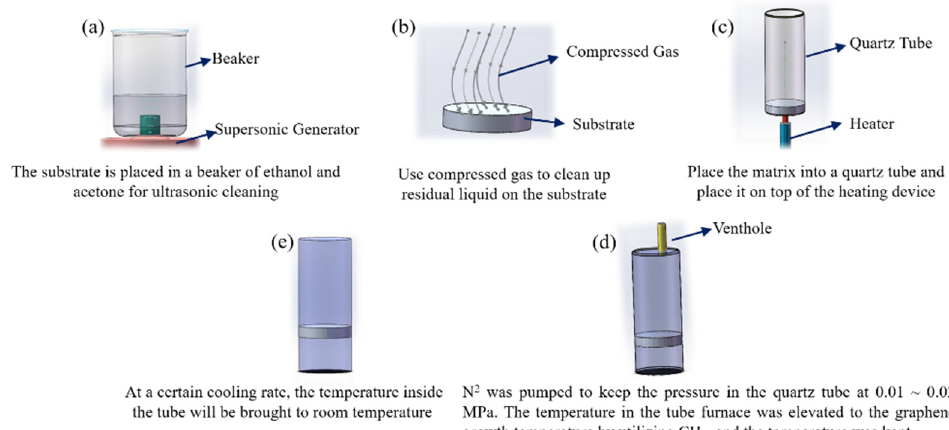
Figure 1. The graphene-based coating preparation process.